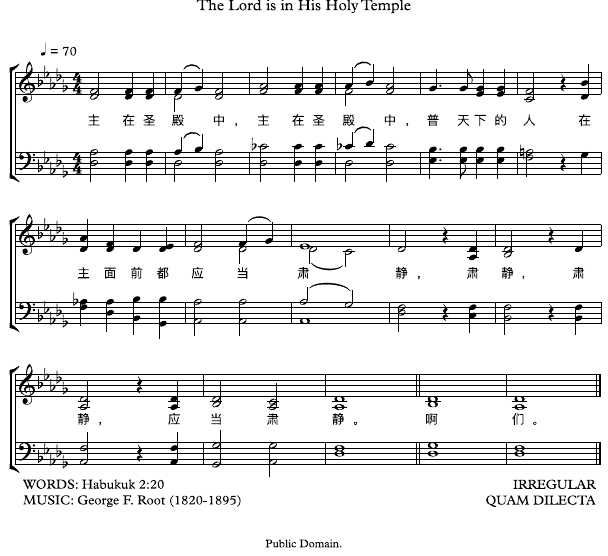
Figure 1. “The Lord Is in His Holy Temple” by George Root.